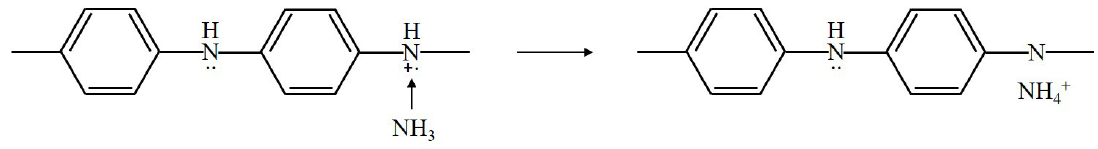
Figure 7. Sensing mechanism of PANi exposed to